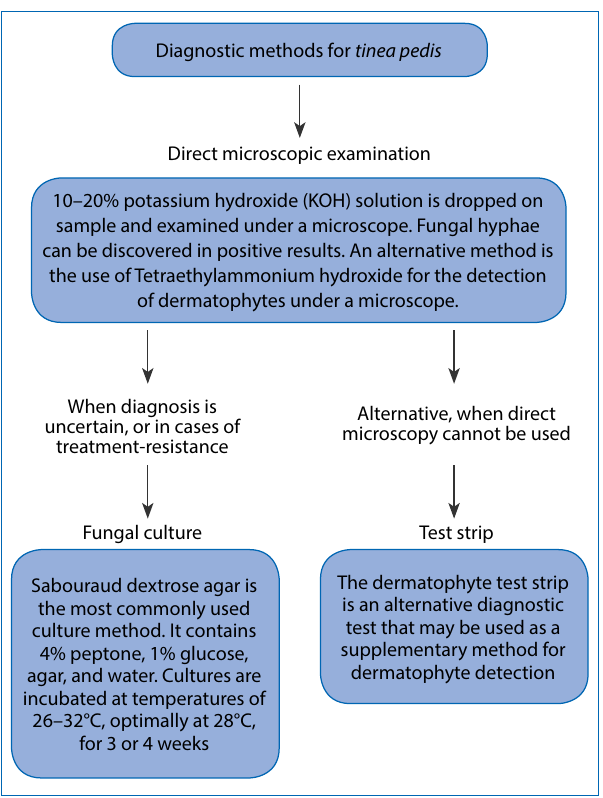
Figure 1: In direct microscopic examinations, scraped-off samples are tinted with 10–20% potassium hydroxide or alternatively tetraethylammonium hydroxide. The samples are then viewed under a microscope for detection of fungal hyphae. In cases of treatment resistance or uncertain diagnosis, a fungal culture is a viable alternative. In cases where direct microscopy is not feasible for use, dermatophyte test strips can provide a diagnosis for dermatophyte detection. 12